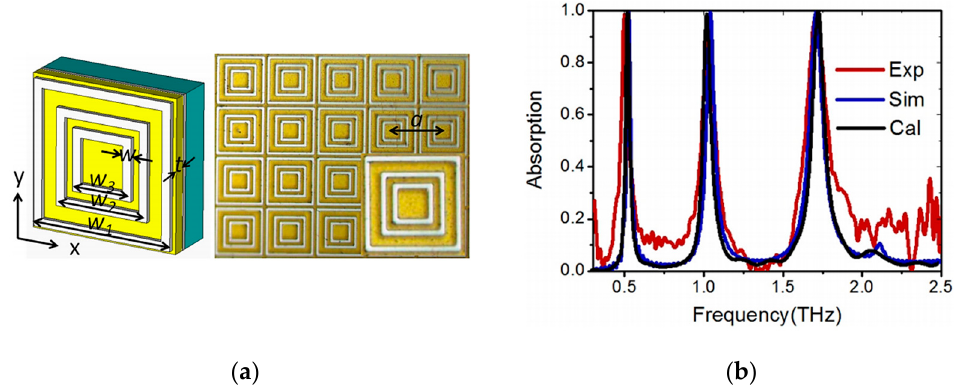
Figure 14. Terahertz tri-band MPA. ( a ) The structure; ( b ) the curve of absorption [52].